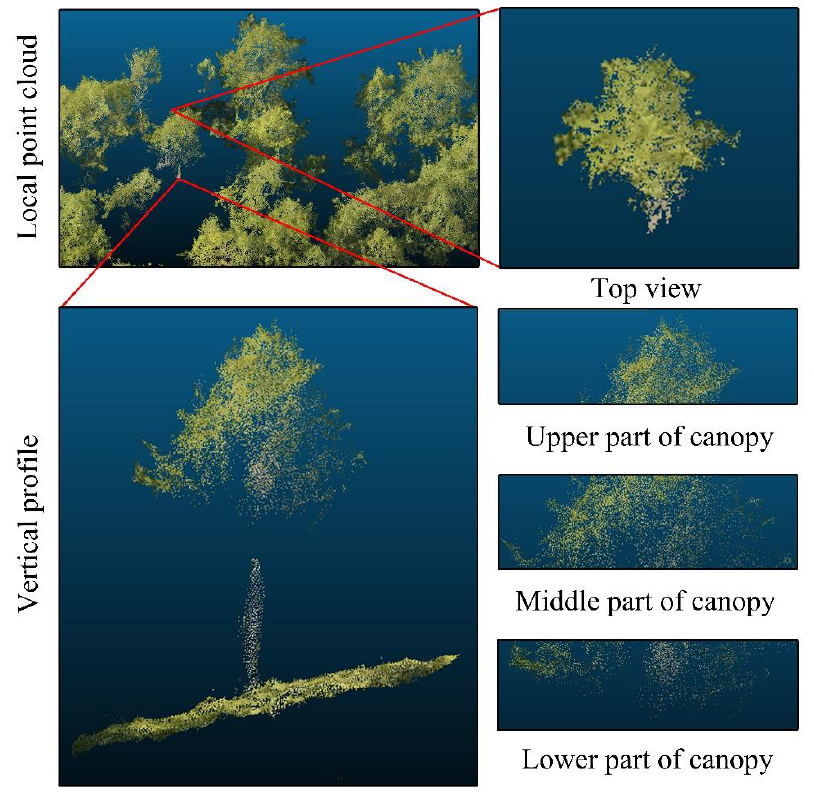
Figure 12. Figure shows the local point cloud of OT30 and the vertical profile distribution of a sin- gle tree. For better display, the ground point clouds are removed. tree. For better display, the ground point clouds are